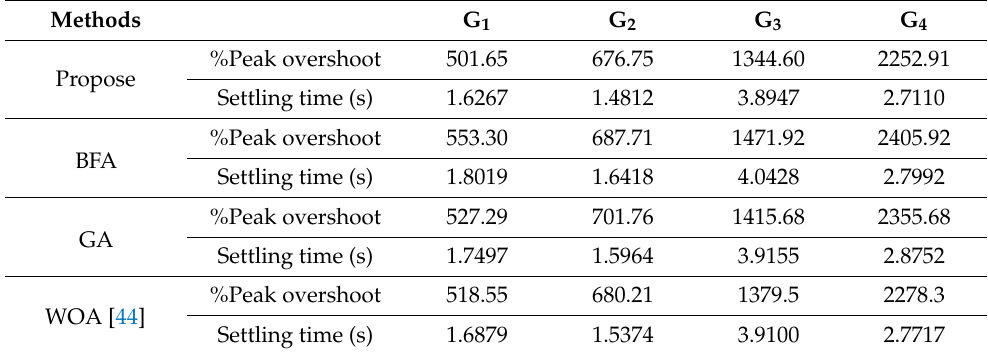
Table 7. Time domain response